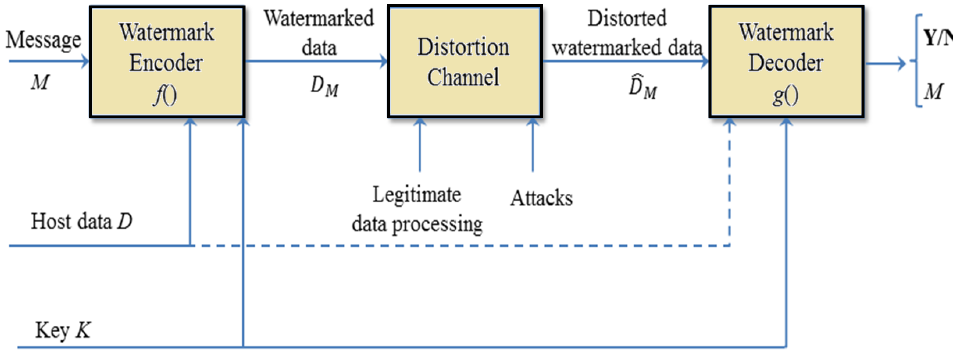
Figure 1. The typical process of watermarking